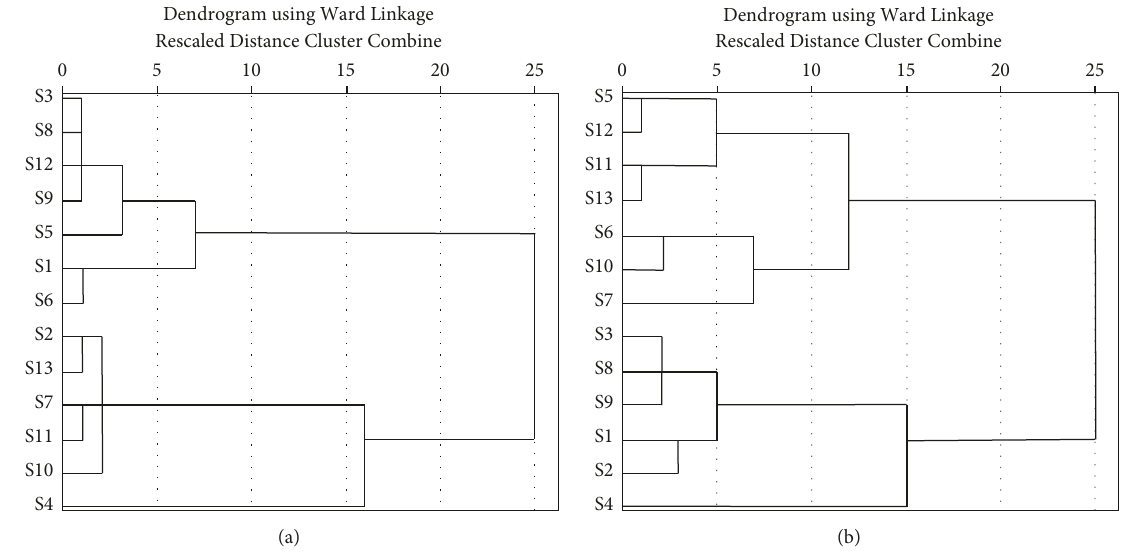
Figure 11: Dendrograms of the clustering results, congested (a) and smooth (b).